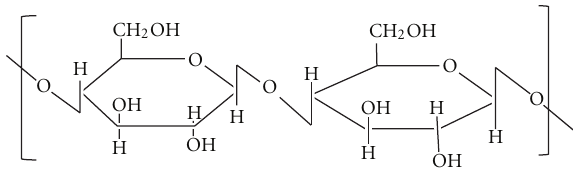
Figure 2: Cellulose